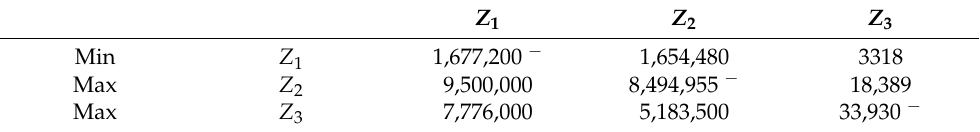
Table 6. NIS Payoff